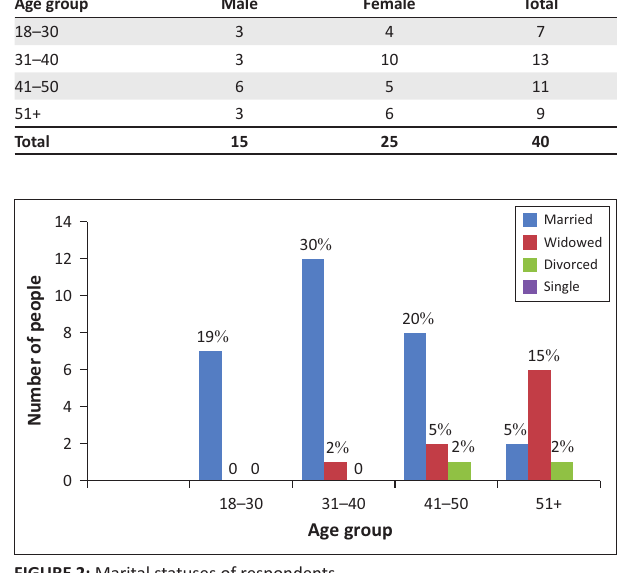
FIGURE 2: Marital statuses of respondents.